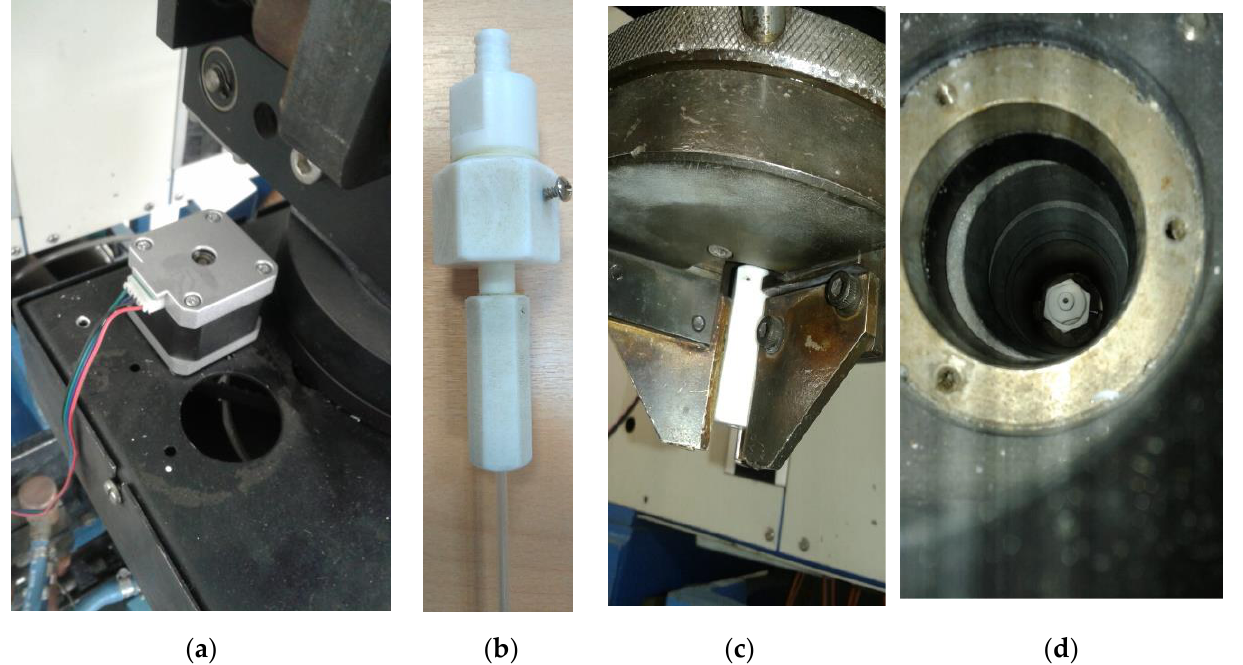
Figure 1. Modifications of the drawing tower feed unit: ( a ) top of the feed unit with installed stepper motor, which rotates a preform under the desired speed; ( b ) completed and jointed fluoroplastic rotational adapter with installed MOF cane; ( c ) the bottom of the feed unit, which chuck holds the rotational adapter and rotates a cane; ( d ) bottom part of fluoroplastic rotational adapter (inside), fixed in the feed unit chuck.